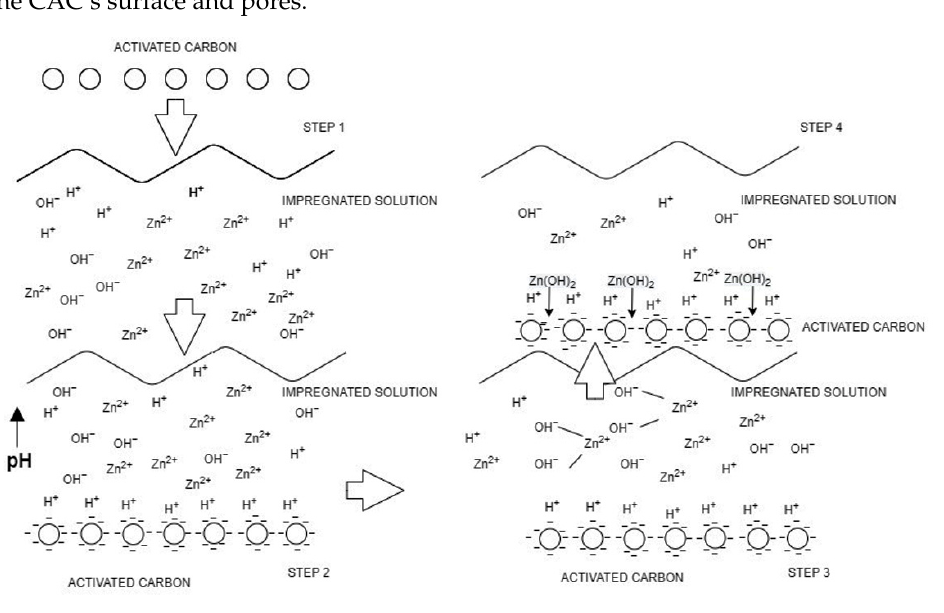
Figure 1. Impregnation step behavior of ZnAc 2 /ZnO/CAC_DCM. ZnAc 2 /ZnO/CAC_OS was prepared under the same parameter as ZnAc 2 /ZnO/CAC_DCM. The influence of pH on ZnAc 2 /ZnO/CAC_OS is shown in Table 2 and Figure